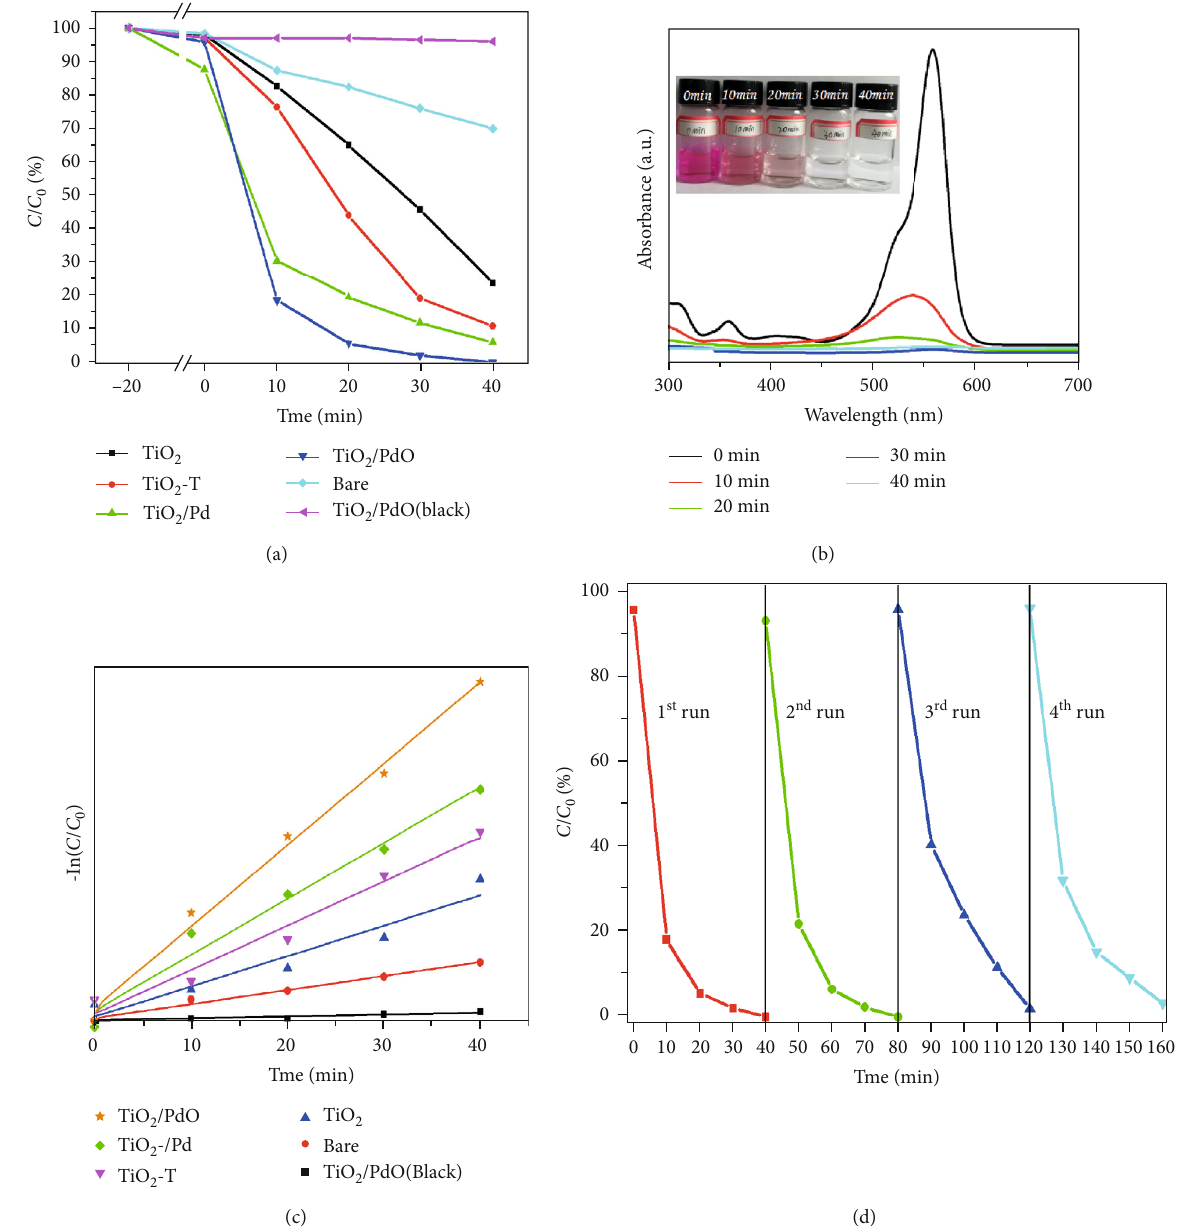
Figure 6: (a) Photocatalytic degradation of Rh B solution with TiO Vis absorption spectra of Rh B in the presence of TiO degradation over TiO degradation of Rh